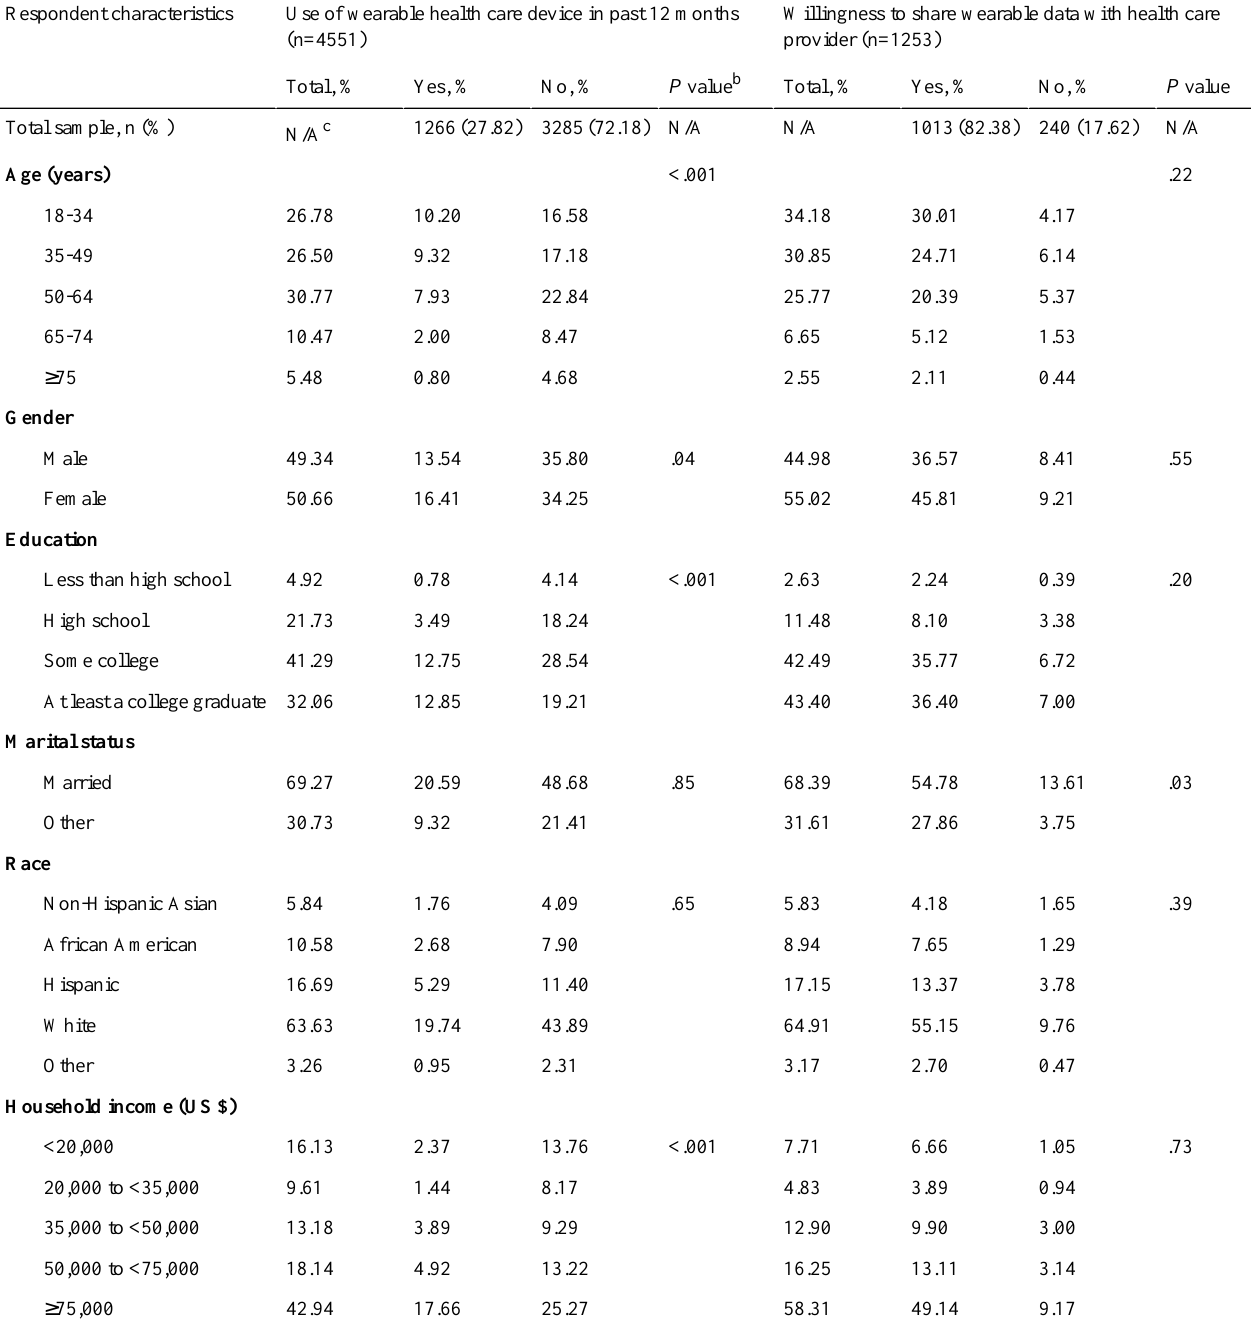
Willingness to share wearable data with health